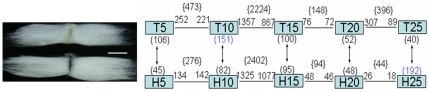
Number of differentially expression genes from interspecific and temporal comparison.A representative image of mature single cell seed trichomes (“cotton fiber”) from cultivar Gossypium hirsutum acc. TM-1 (up) and Gossypium barbadense cv. Hai7124 (down) (bar = 9.5 mm). Microarray analysis was performed for three replicates of each of five stages (represented by boxes) for both accessions. T5-T25 and H5-H25 were indicated microarray samples for TM-1 and Hai7124 at 5, 10, 15, 20, and 25 DPA, respectively. Numbers marked on the line designate the number of genes up-regulated at least 2-fold (FDR<0.01) relative to their adjacent developmental stage, with the total given in brackets {}. Numbers marked in brackets ( ) denote the numbers of differentially expression genes between TM-1 and Hai7124 at each stage.